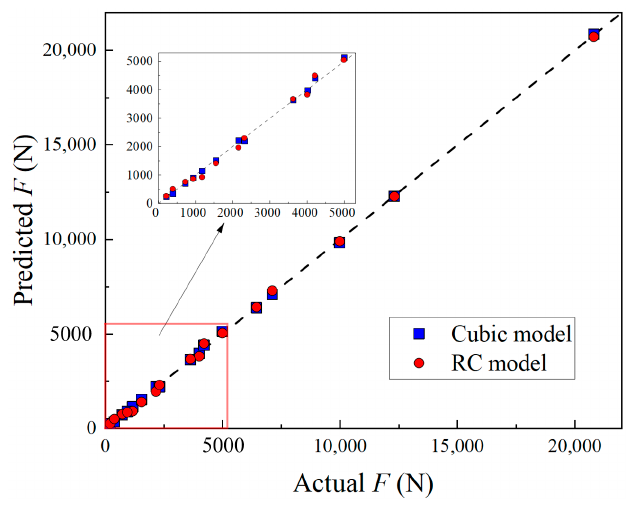
Figure 18. Cubic and RC models predictions for the F values. Figure 19 presented the response surface of the ultimate load for the RC model. The oval isoheights from the contour plot (Figure 19a) represented that the interaction be- tween the regression variables D / t and p were significant. Additionally, from the three- dimensional response surface hyperplane (Figure 19b), it was found that the design points sat basically on the response surface, which indicated that the predicted values of the re- gression model were in good agreement with the actual values. The deviation values for the RC model and FEM of each design point (Table 4) were less than 5%, which indicated that the RC model was highly authentic. Therefore, the proposed design expression had the potential to serve as a feasible alternative to the FEM for assessing the ultimate loading of the inflated composite membrane structure within the interesting range.